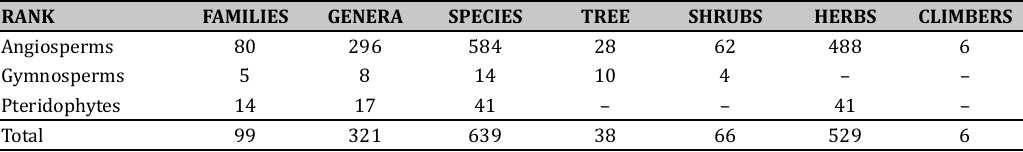
Table 1. Different taxonomic groups and number of